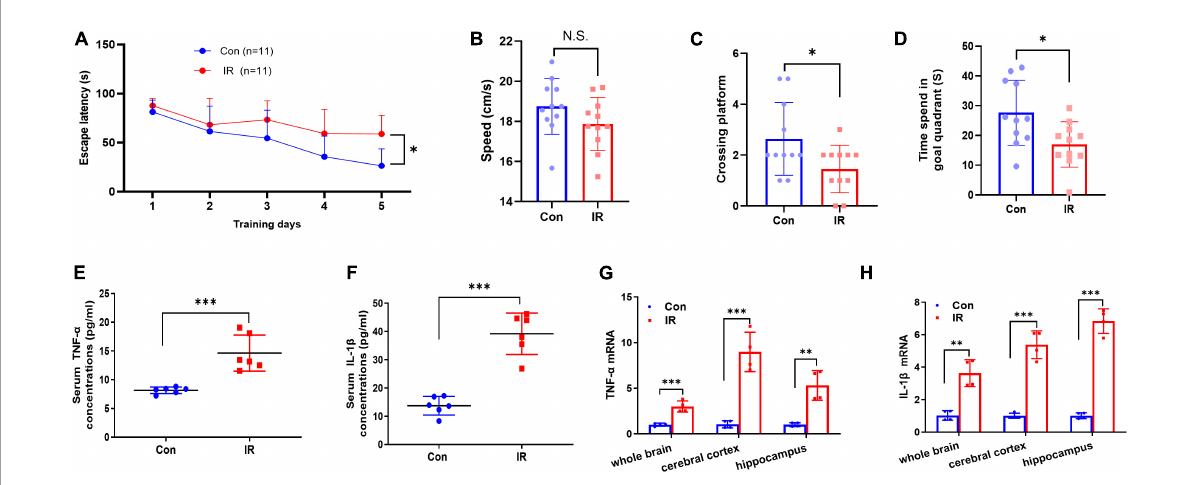
FIGURE2 MWM test and proinflammatory factors expression in serum and brain. (A–D) The results of MWM test, n = 11 per group. (A) The escape latency to reach the platform during navigation training session on different day. (B) The swimming speed. (C) Platform crossing frequency. (D) Resident duration in goal quadrant. (E,F) The pro-inflammatory cytokines TNF α (E) and IL-1 β (F) concentrations in serum. n = 8 per group. (G,H) The mRNA expression of pro-inflammatory cytokines TNF α (G) and in IL-1 β (H) in different brain areas. n = 3 per group. Data are expressed as mean ± SD. * p < 0.05, ** p < 0.01, *** p <